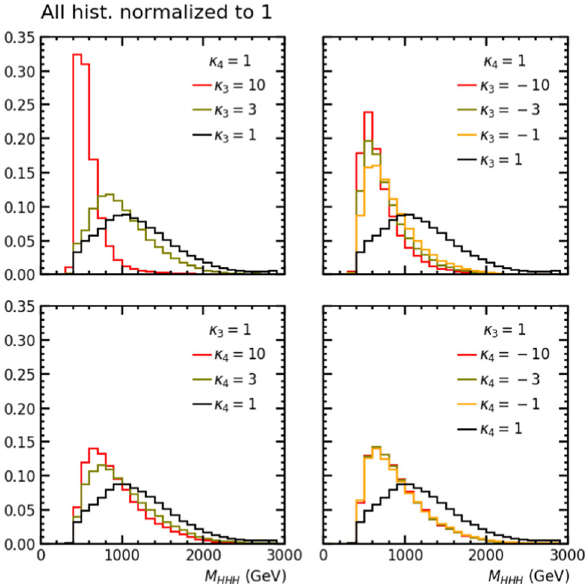
Fig. 30 Distribution of e + e − → b ¯ bb ¯ bb ¯ b ν ¯ ν events with respect to the invariant mass of the three Higgs bosons, that is, of the six b -jets, for several values of the parameters κ 3 and κ 4